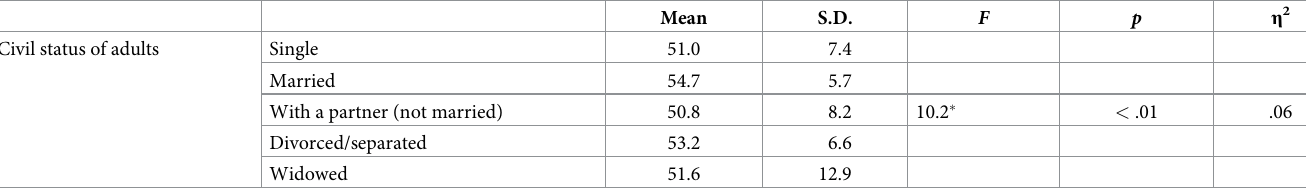
Table 5. Analysis of variance of the effect of civil status on compliance with the preventive